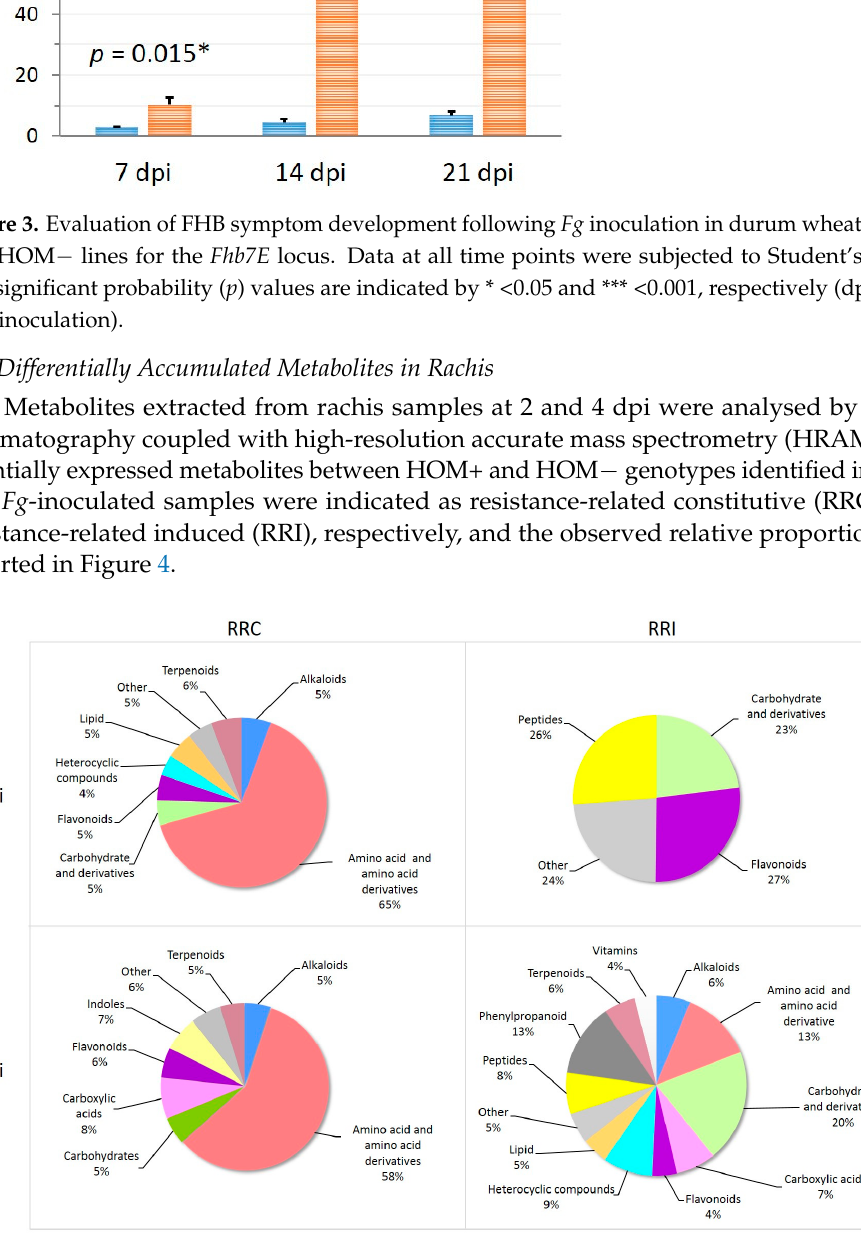
Figure 4. Chemical diversity of differentially accumulated metabolites at 2 and 4 days post inoculation (dpi) with water (RRC = Resistance-Related Constitutive) or Fg (RRI = Resistance-Related Induced), in the rachis samples of the resistant, Fhb7E HOM+ vs. susceptible HOM − lines.